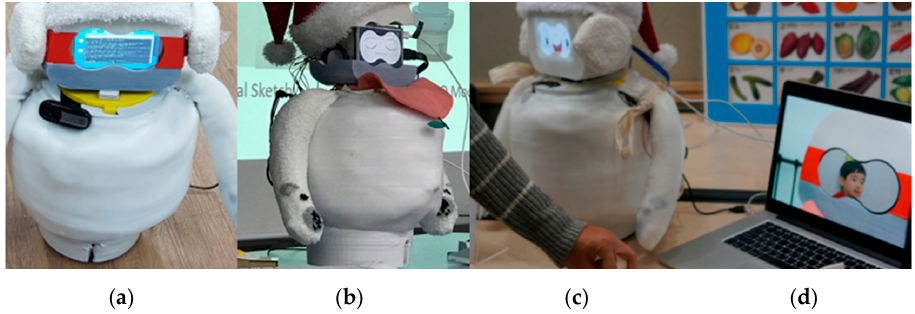
Figure 7. Facial expression control on the LCD of robot head: ( a ) console window; ( b ) draft facial. ( c ) smile facial, and ( d ) Imagination of special memory mode that parents and children can frequently load.